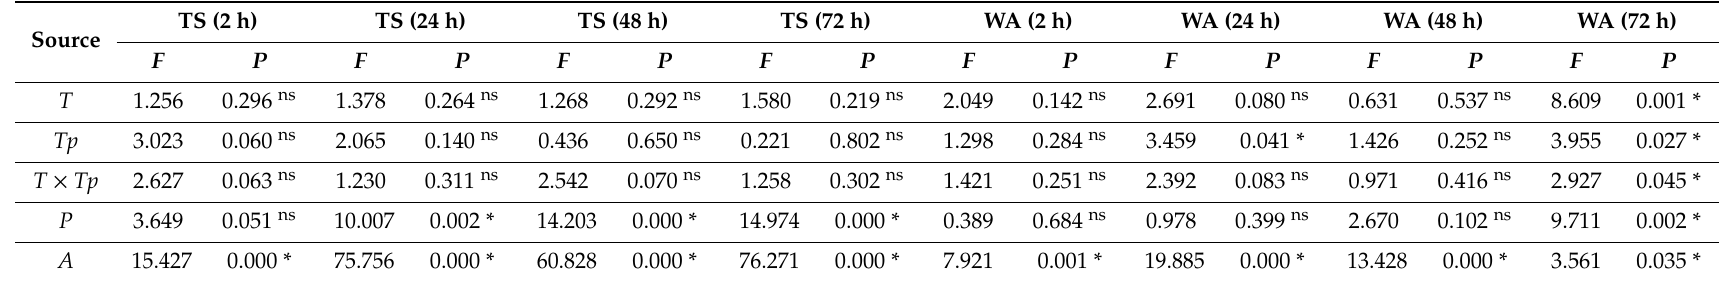
Table 3. ANOVAs of the variable parameters on the physical properties of plywood